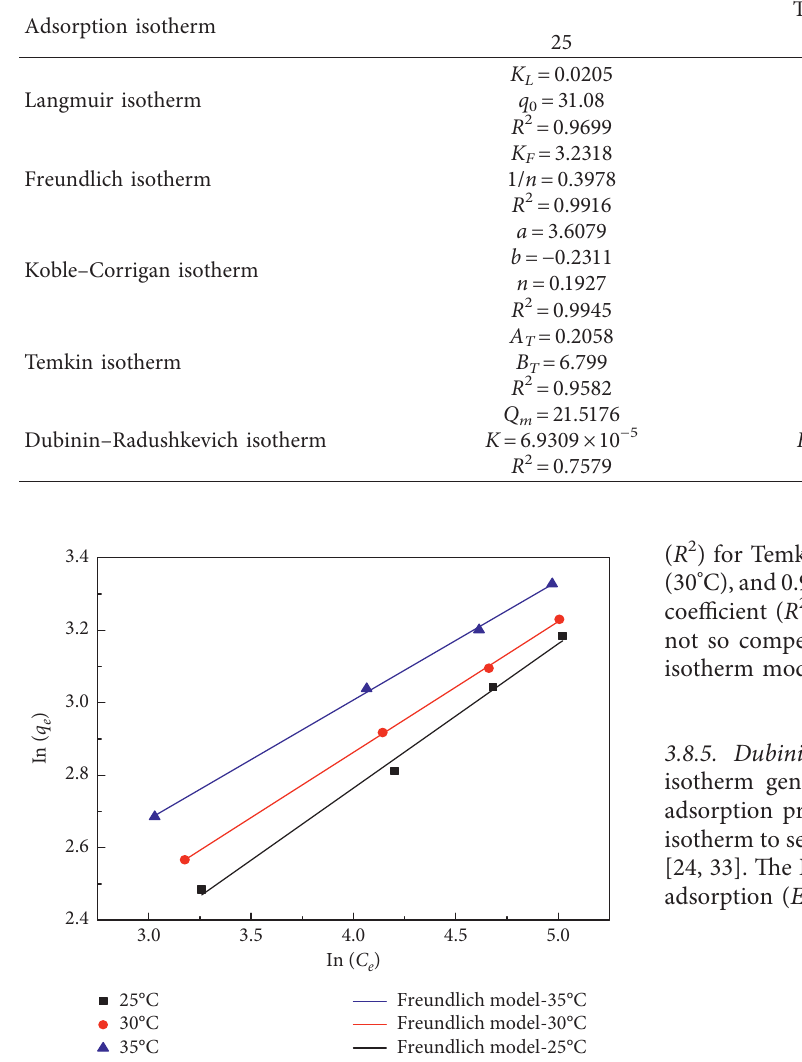
Figure 11: Freundlich isotherm plots for the uptake of ammonium on the